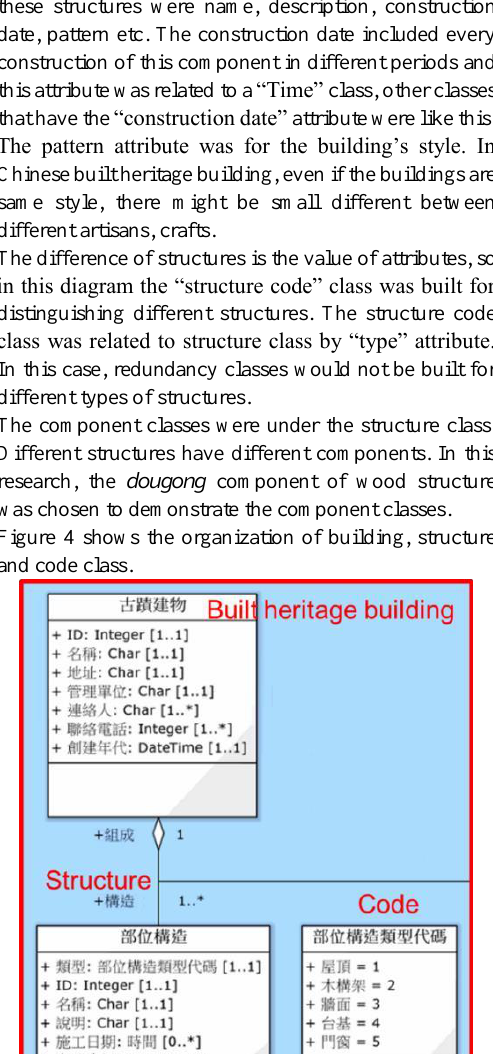
Figure 4. Organization of